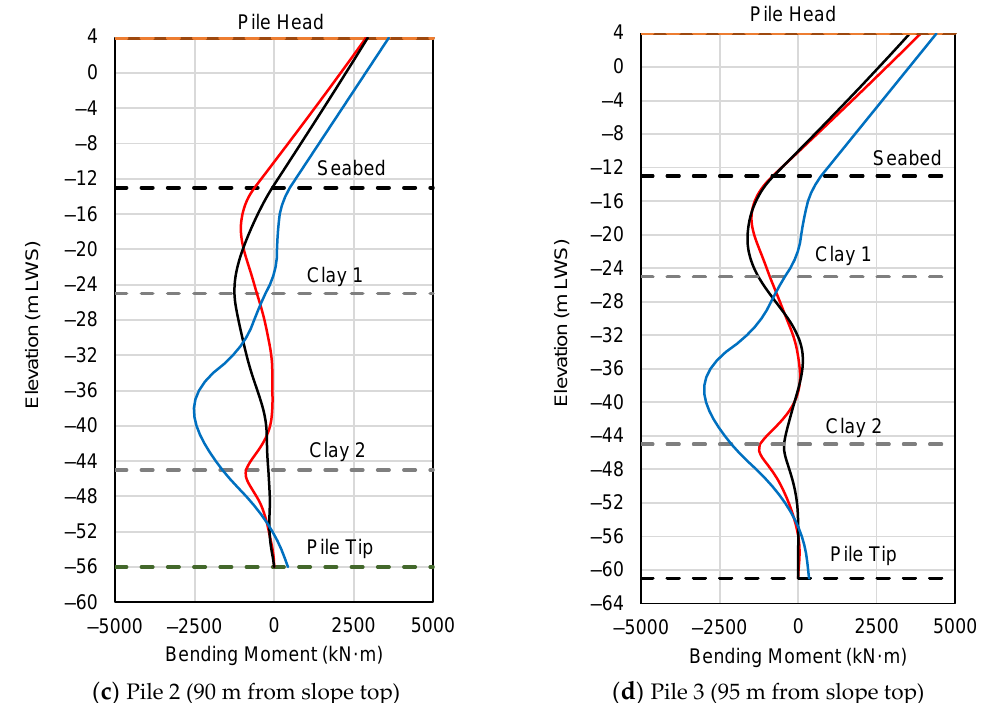
Figure 17. Bending moment distribution of the PSW considering the inertial and kinematic forces due to the ME waveform (Scenario 2).